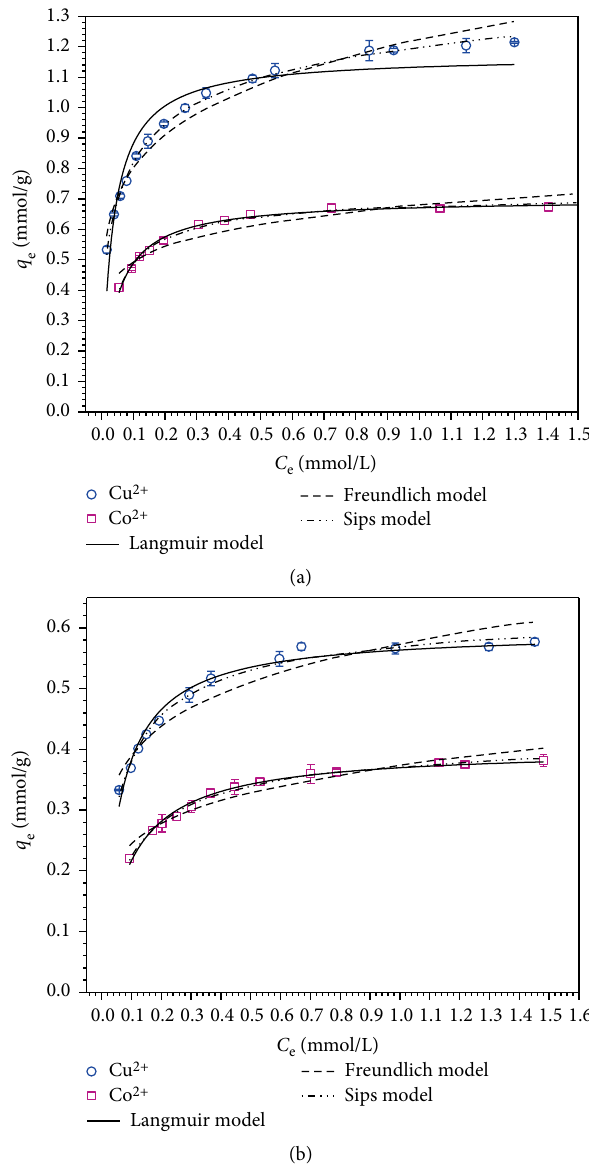
Figure 3: Isotherms for adsorption of Cu 2+ and Co 2+ on (a) Cox and (b) SBox (pH 5.5, 25°C, 150 rpm, and 0.2 g/L Cox or